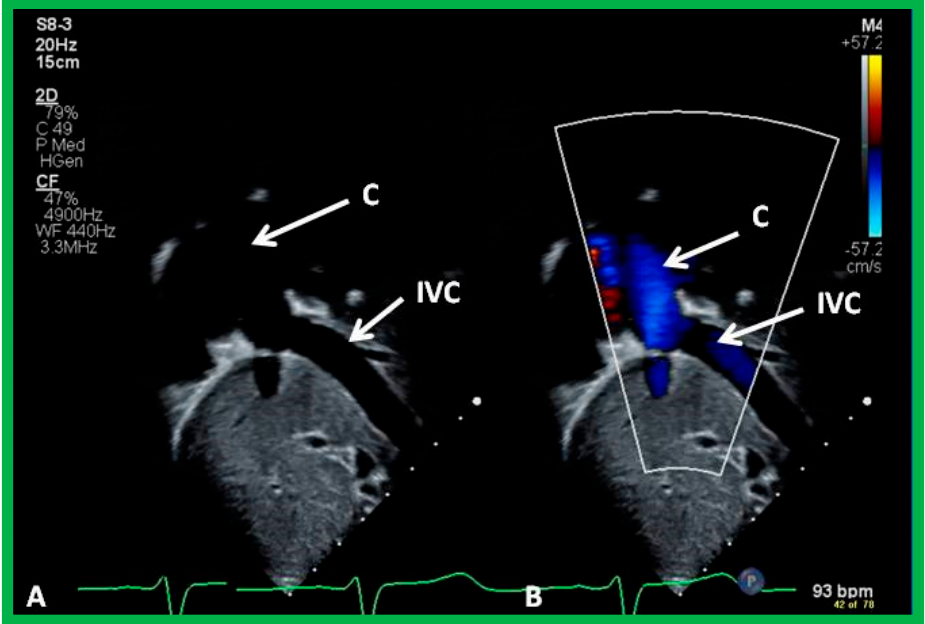
Figure 7. Selected video images by two-dimensional ( A ) and color echo–Doppler ( B ) illustrating anastomosis of the inferior vena cava (IVC) with a non-valved conduit (C). Note that the inferior vena cava to conduit connection is wide open. Reproduced from [21].